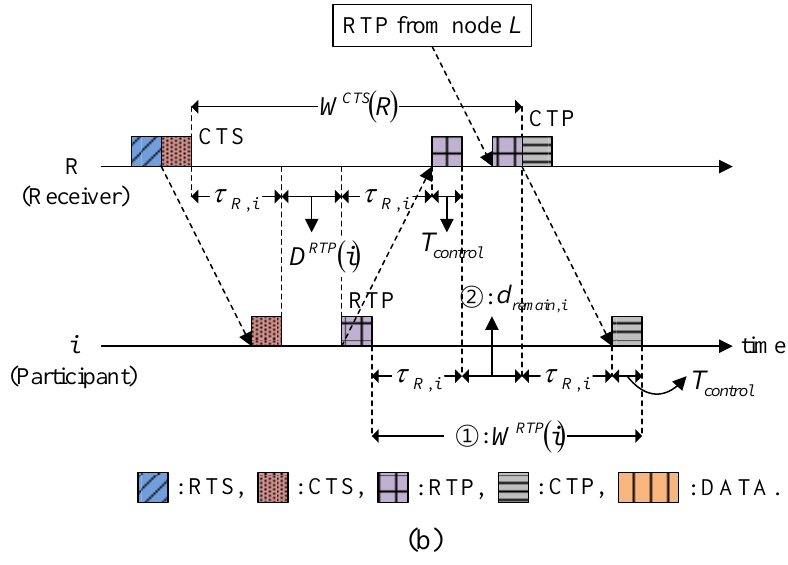
Figure 9. Determination of the Waiting for responses: ( a ) Associated with CTS and CTP; and ( b ) Associated with